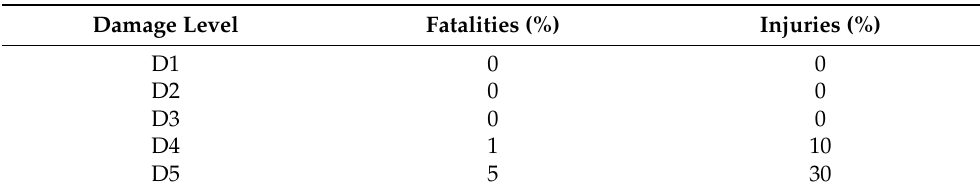
Table 6. Matrix 3—Percentage of fatalities or injuries. Reprinted with permission from [19]. Copy- right 2020, Borzi et. al.